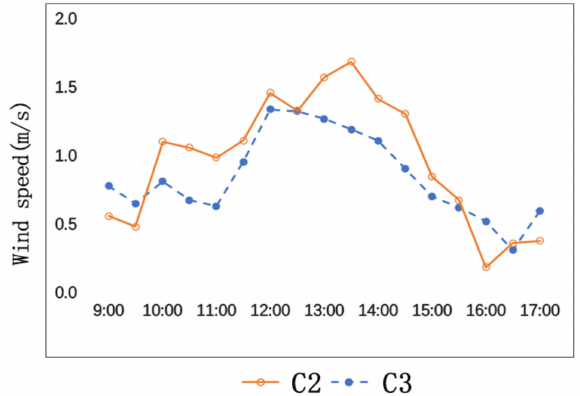
Figure 6. Comparison of wind speeds of C2 and C3.